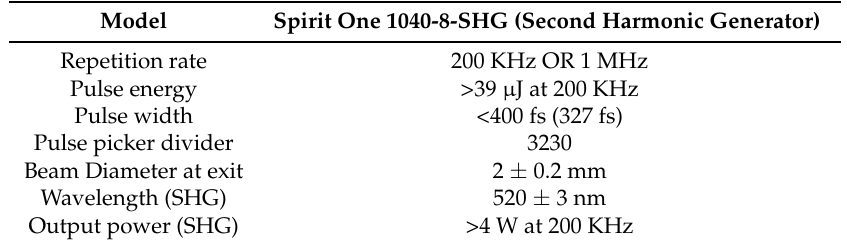
Table 2. Laser parameters.